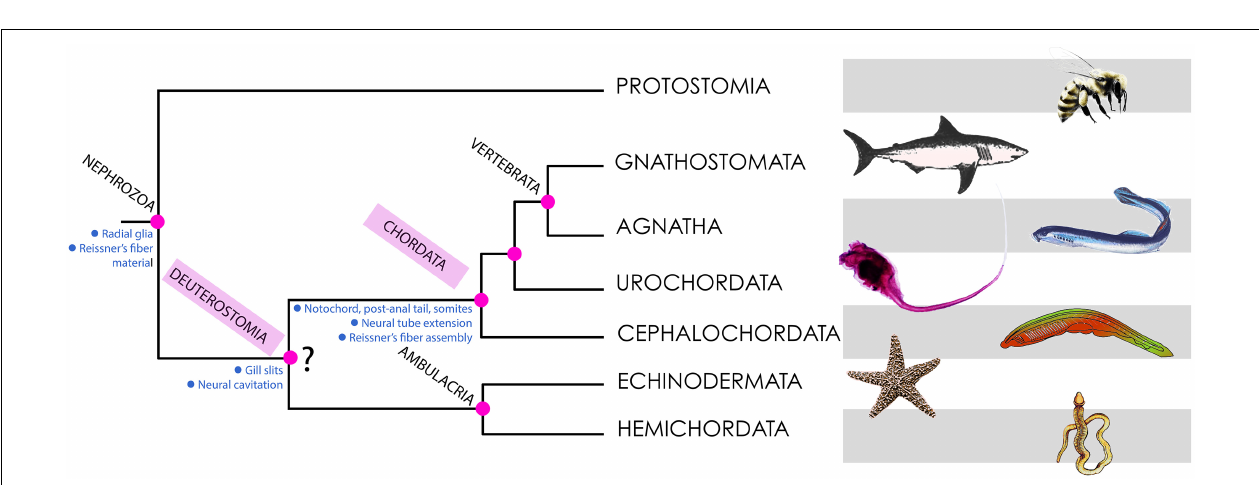
FIGURE 1 | Diagram of the basic elements of the chordate body plan, featuring a tadpole-like animal with a fibrous notochord (N) and a hollow neural tube (NT) in the dorsal side (cavitation is shown in dark green), a muscular tail (MU) for swimming, and gill slits (GS, a character shared with other deuterostomes). A, anus; H, heart; M, mouth.